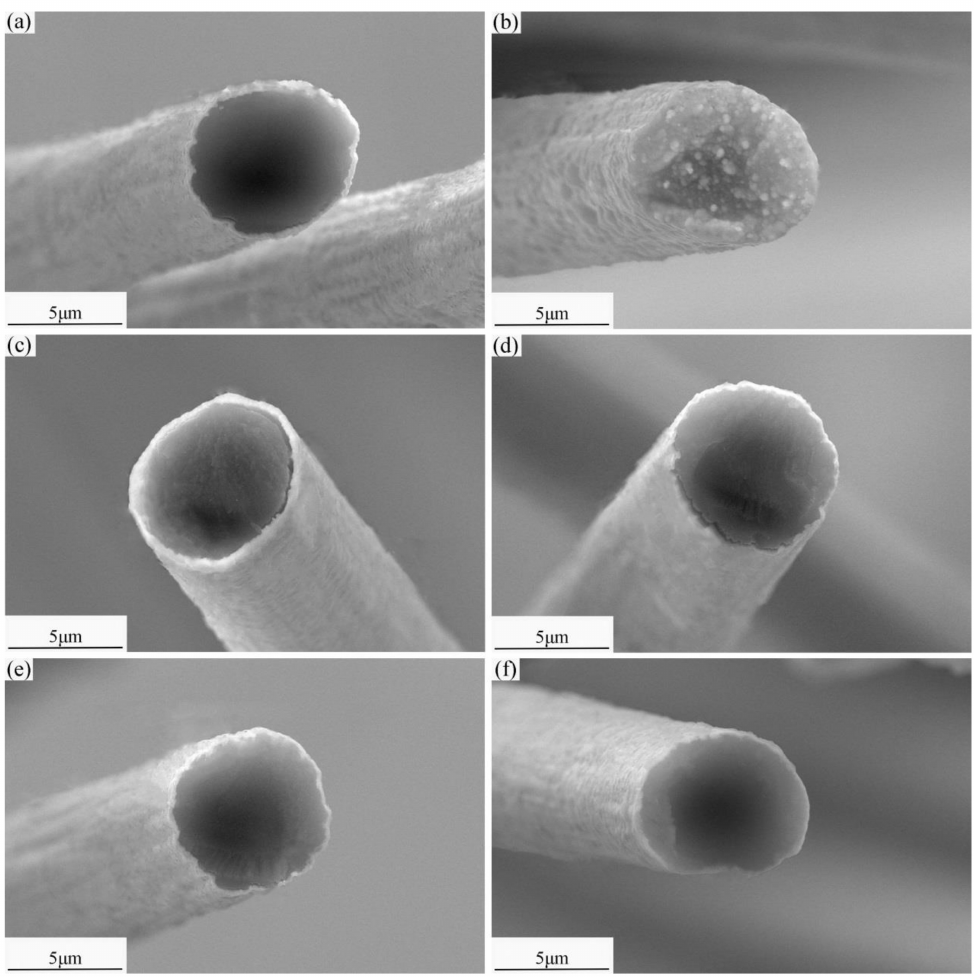
Figure 3. SEM images of the interface microstructures of the modified SCFs: ( a , b ) Ni-Cf; ( c , d ) Cu-Cf; ( e , f ) Cu-Ni-Cf; ( a , c , e ) before heat treatment; and ( b , d , f ) after heat treatment.